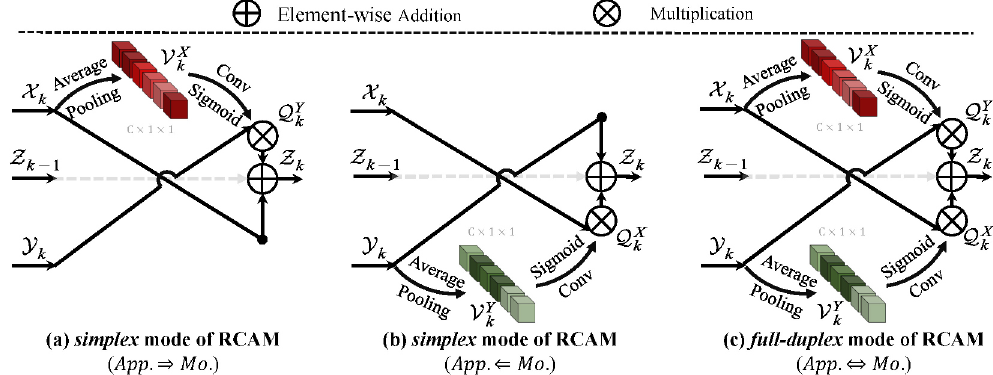
Fig. 4 Relational cross-attention module (RCAM) with simplex (a, b) and full-duplex (c) strategy.